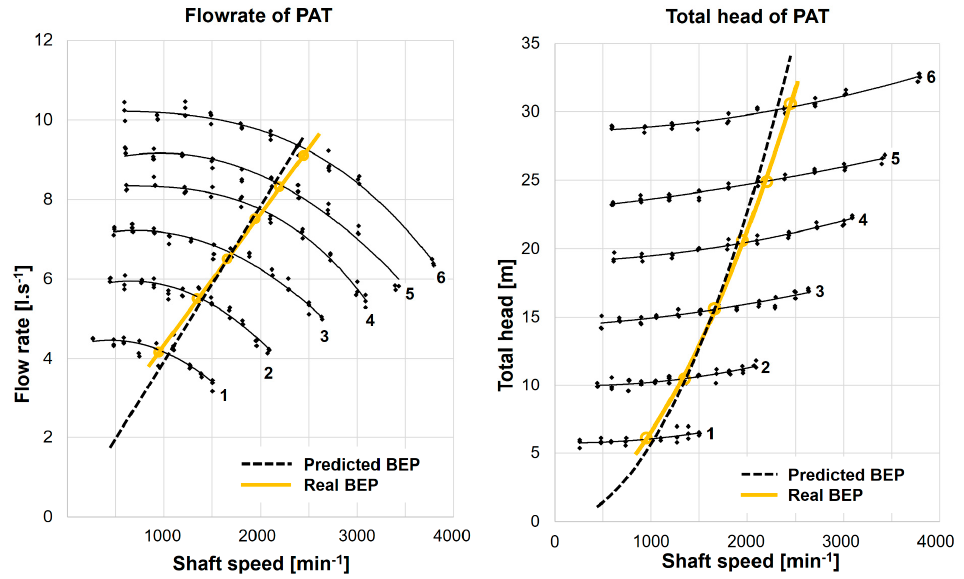
Figure 6. Predictive calculations of flow rate and total head versus reality.